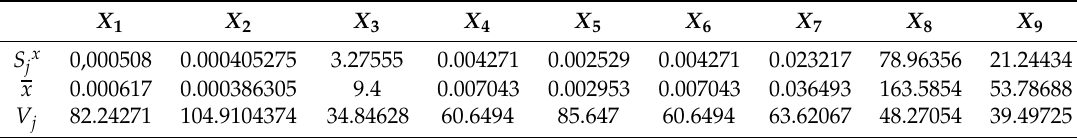
Table 3. Results of the calculation of the coe ffi cient of variation for potential diagnostic features for a 2018 year (own study).